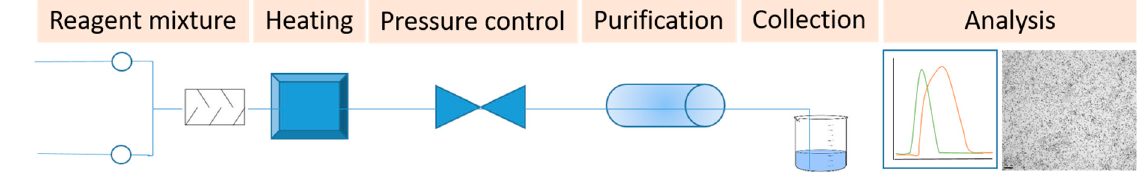
Figure 1. Schematic representation of a continuous flow setup for large-scale production of magnetic nanoparticles.